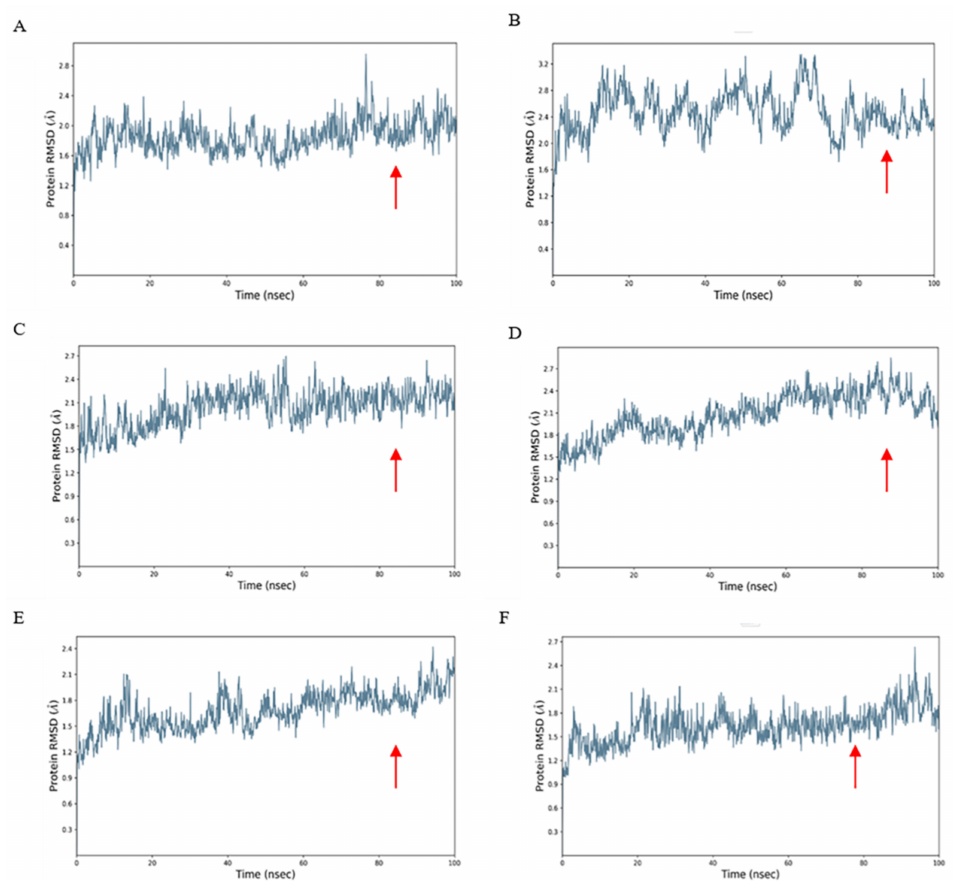
Figure 3. RMSD of the docking structure. The arrow (red) indicates the selected stable regions, where the value fluctuates slightly and can be used for subsequent calculations of the binding free energy. ( A ) The complex 5GRD-SMYPSCCCTK remained stable between 10 and 100 ns. ( B ) The complex 1I4F-SMYPSCCCTK remained stable from 80 to 100 ns. ( C ) The complex 3RL2-SMYPSCCCTK remained stable between 60 and 100 ns. ( D ) Compound A * 26:01-ETVLEYLVSV remained stable from 60 to 100 ns. ( E ) Compound 5GRD-ETVLEYLVSV remained stable from 60 to 100 ns. ( F ) Compound 3UTQ-ETVLEYLVSV remained stable from 20 to 100